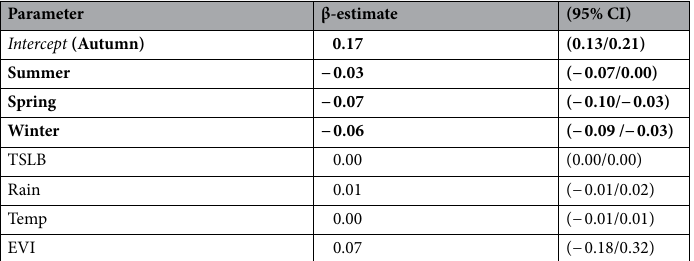
Table 4. The observed relationship between the response variable (EMD) and the model-averaged parameters from each top model (β-estimate ± 95% CI) for the same seasons between consecutive years. Temp temperature, BIS percentage of UD burned within season, BLS percentage of UD burned in last fire before season, TSLB time since last burn in UD before season. See Table S5 for individual seasonal comparisons. The β-estimates with CI that do not overlap zero are indicated in